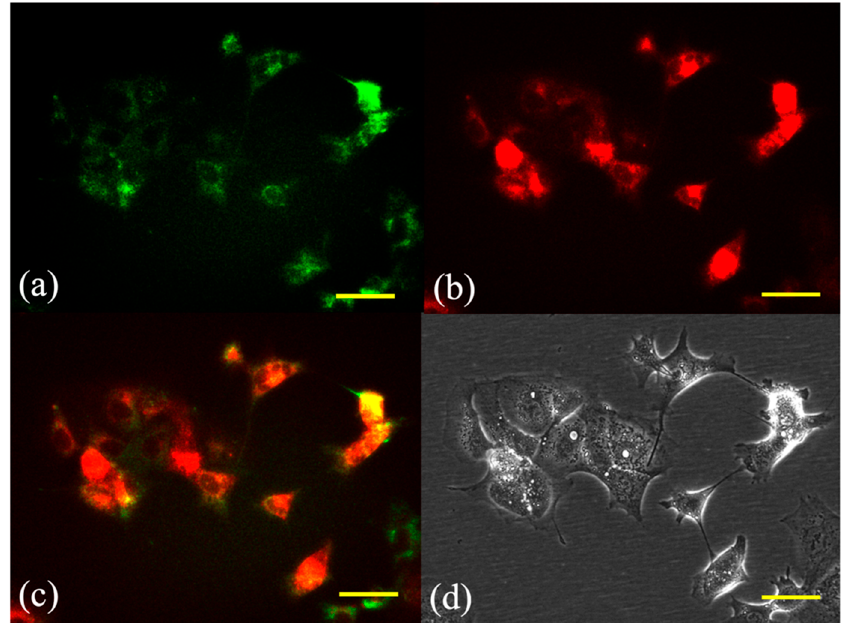
Figure 2. Subcellular localization of glucose-conjugated chlorin e6 in the mitochondria after 6 h of incubation. The subcellular localization of glucose-conjugated chlorin e6 (G-Ce6) was characterized using fluorescence microscopy. ( a ) Green fluorescence of MitoTracker Green FM stained mitochondria, ( b ) red fluorescence of G-Ce6 in the same view as ( a ), ( c ) combination of ( a ) and ( b ) images, and ( d ) transmission images. Scale bar, 50 μ m.